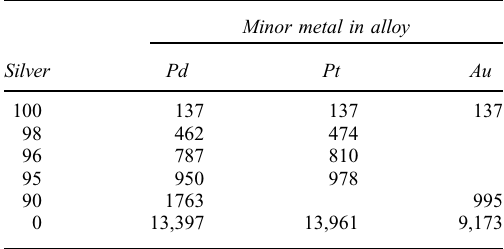
TABLE II Metal Price of Different Metal Alloys Powders.